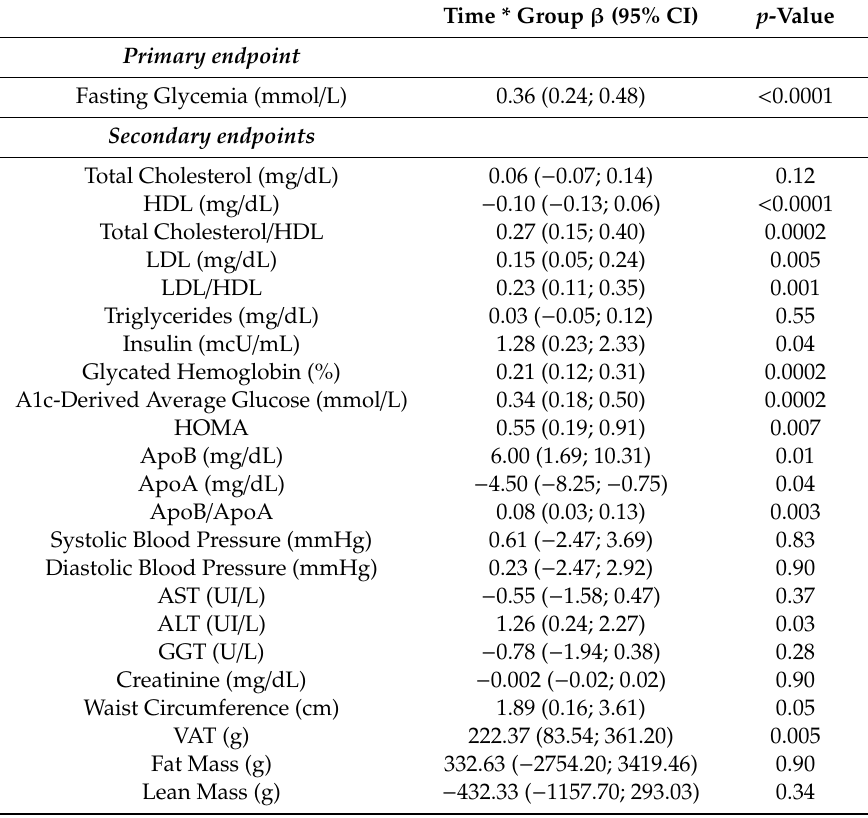
Table 3. Between-group pre-post supplementation di ff erence for primary and secondary endpoint. Estimate of time * treatment ( β ), 95% confidence interval (CI) and the adjusted p -value of the null hypothesis of a no e ff ect are